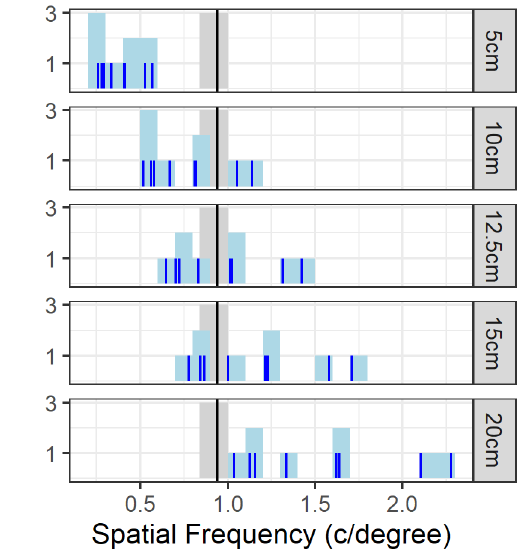
Figure 5. Visual acuity in c/degree. The SF with an expected performance of 70% (in c/degree) calculated based on several assumed viewing distances (in cm); shaded area: Acuity range with mean ( | ) according to